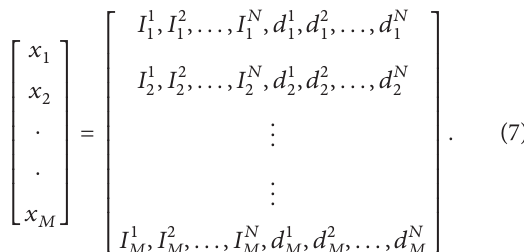
Case 3 (nonuniform amplitude distribution with nonuniform spacing and without beam steering). Nonuniform spacing along with nonuniform amplitude distribution is